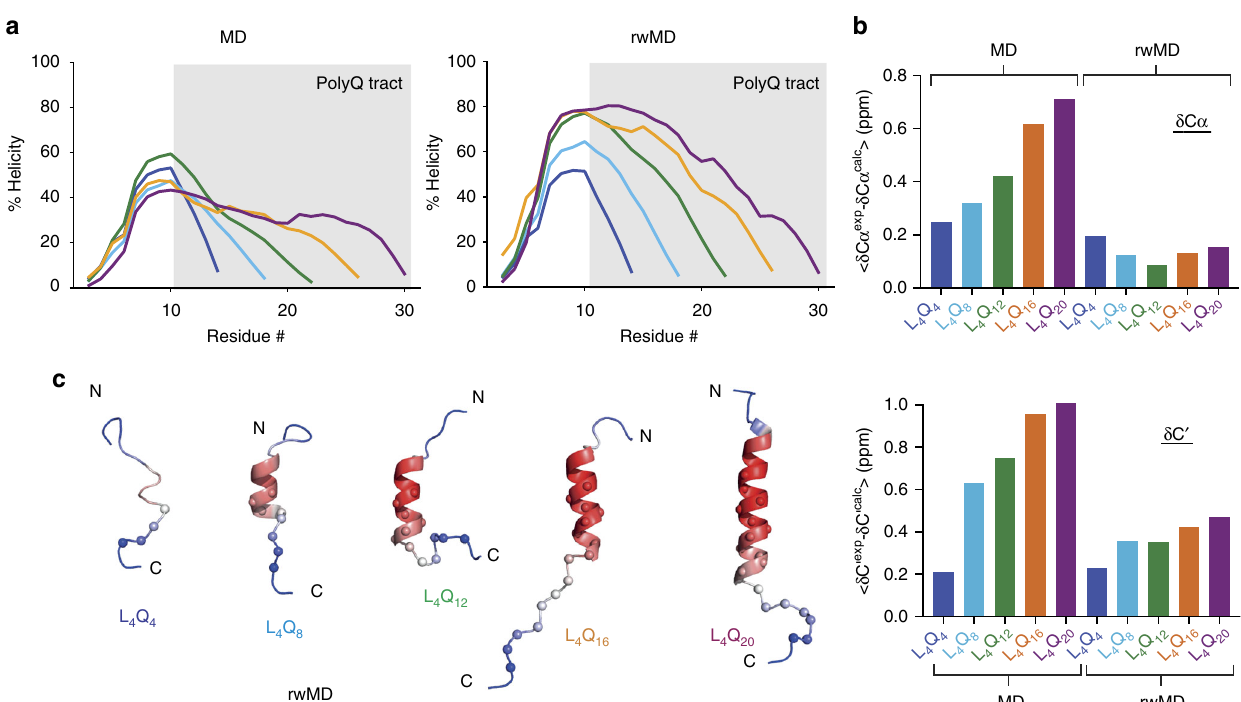
Fig. 3 The structural properties of polyQ helices are tract length dependent. a Residue-speci fi c helicity obtained for peptides L 4 Q 4 to L 4 Q 20 before (molecular dynamics (MD)) and after reweighting (rwMD) the trajectories obtained by MD on the basis of the backbone chemical shifts. b Comparison of the difference between the experimental and back-calculated C α and C ′ chemical shifts with those back-calculated from the reweighted MD trajectories obtained for peptides L 4 Q 4 to L 4 Q 20 . c Representative structures for peptides L 4 Q 4 to L 4 Q 20 , de fi ned as the frame of each trajectory with residue-speci fi c helicity most similar to the ensemble-averaged counterpart. Residues are colored as a function of their average helicity (in the reweighted ensemble) and the C α atoms of Gln residues are shown as